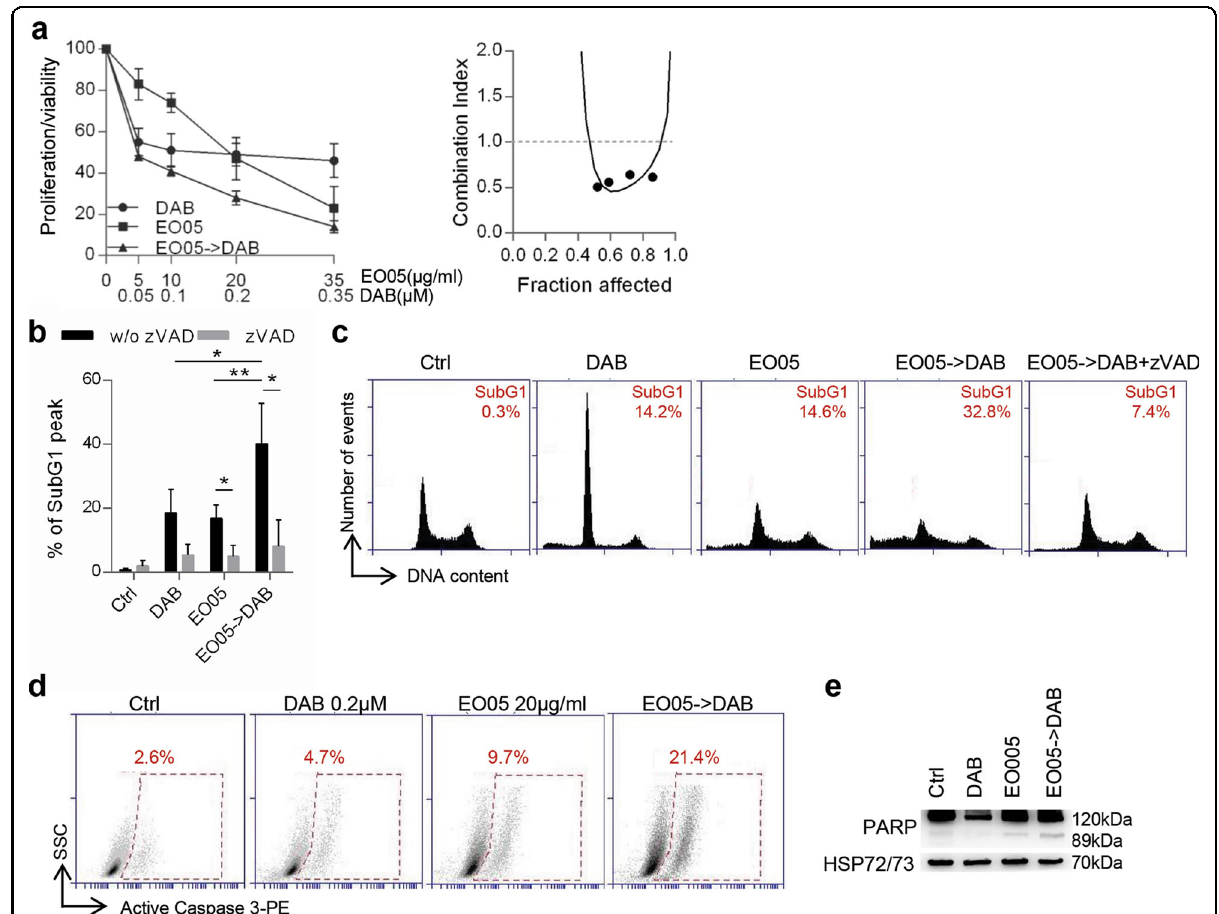
Fig. 3 EO05 sensitizes M14 melanoma cells to dabrafenib treatment. a Analysis of cell proliferation/viability by MTT assay (left) and relative isobologram (right) of M14 cells after treatment with dabrafenib (DAB) or EO05 alone or 24 h EO05 followed by 48 h dabrafenib (EO05-> DAB). The results are reported as “ cell proliferation-viability of treated cells/cell proliferation-viability of control cells (Ctrl) × 100 ” . b Quanti fi cation and c representative images of subG1 peak by propidium iodide staining of M14 cells treated with DAB (48 h, 0.2 μ M), EO05 (24 h, 20 μ g/ml) or with 24 h EO05 followed by 48 h dabrafenib (EO05- > DAB) in the presence or absence of zVAD (50 μ M). The percentage of cells in the subG1 peak is reported. a , b The results represent the average±standard deviation of three independent experiments. Experiments with zVAD were repeated twice. b p -values were calculated between cells treated with combination and cells treated with single drugs, or between cells treated or not treated with zVAD. * p < 0.05; ** p < 0.01 after applying Student ’ s t test. d Flow cytometric analysis of active caspase 3-PE staining in cells treated with DAB (48